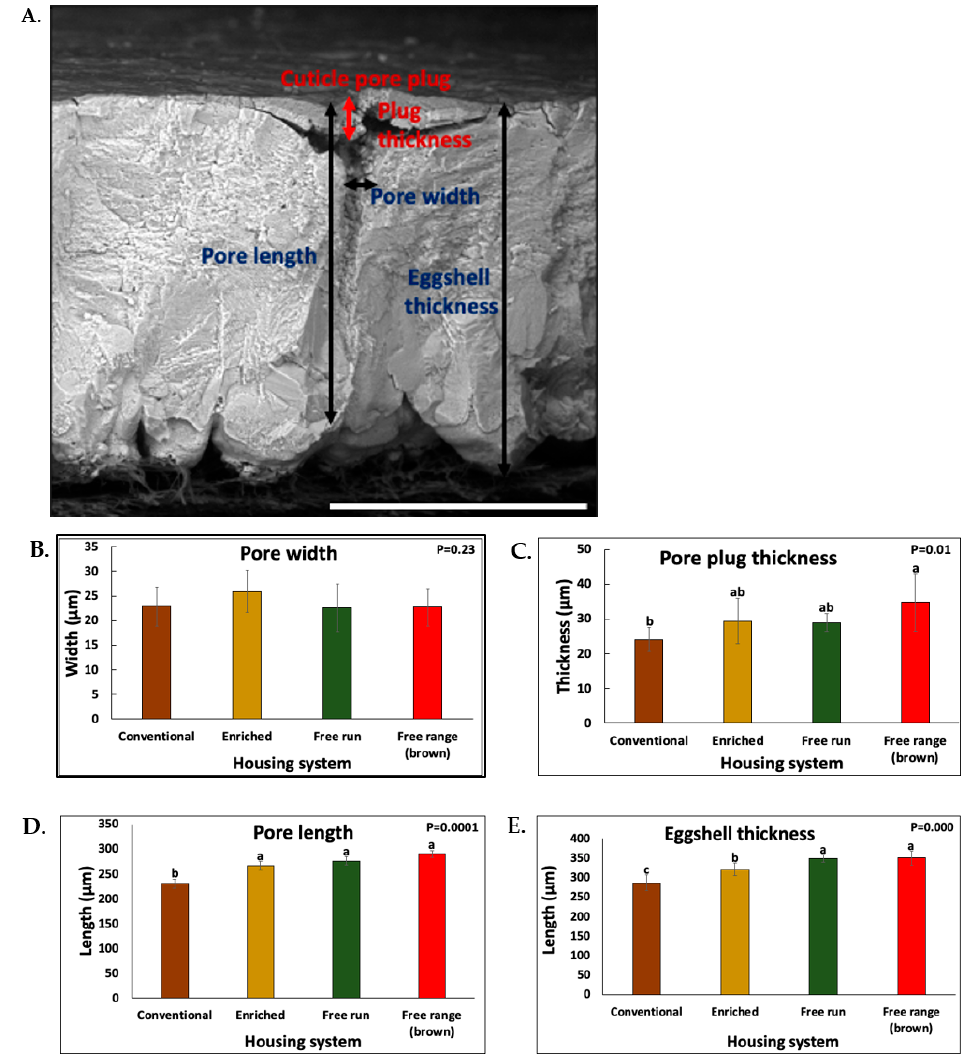
Figure 1. ( A ) The cross fractured eggshell surface showing the cuticle pore plugs as visualized by a scanning electron microscopy (SEM) at 1000 × . The comparison of the eggshell cuticle pore plug parameters ( B ) Pore width, ( C ) Pore plug thickness, ( D ) Pore length, and ( E ) Eggshell thickness in eggs that were obtained from different housing system. SEM images ( n = 18/housing system) were used to quantify cuticle pore plug parameters using the ImageJ software. The data shown corresponds to eggs from mid-lay hens. The values with different superscript letters (Tukey multiple means comparison) are significantly different (ANOVA; p < 0.05). The values represent the mean ± standard deviation from six independent experiments ( n = 18/housing system).